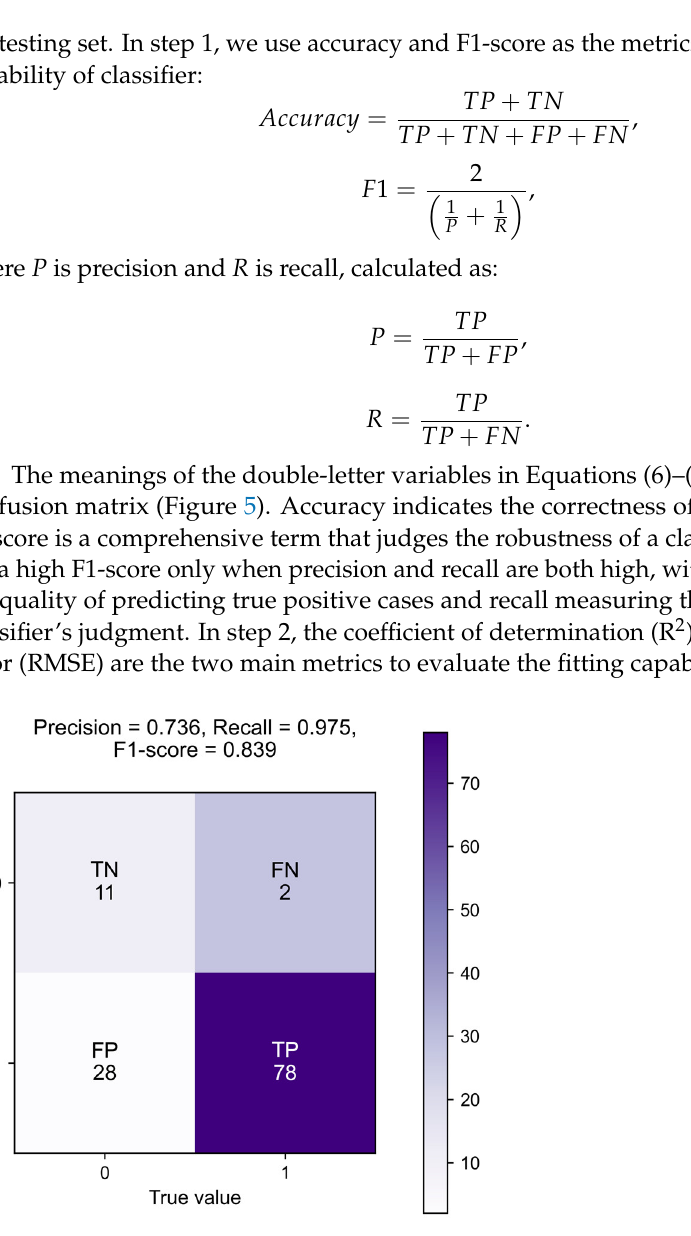
Figure 5. Confusion matrix with best score in testing set by AdaBoost classifier in step 1. Numbers in squares indicate amount of corresponding TC cases. For both true and predicted value, 0 refers to TD/TS (negative) and 1 refers to major TC/minor TC